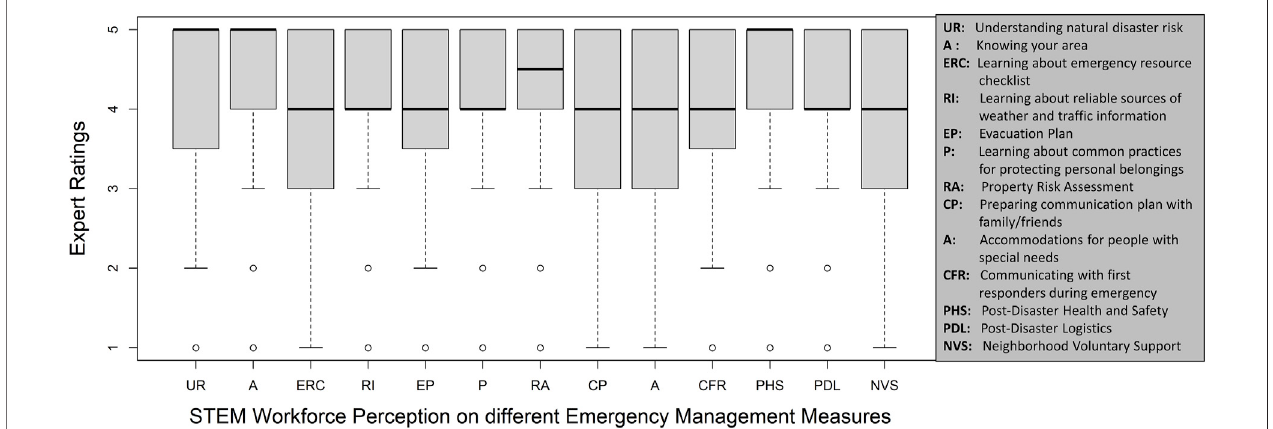
FIGURE 2 | Box plots for the respondents ’ interest in Disaster preparedness topics, n =